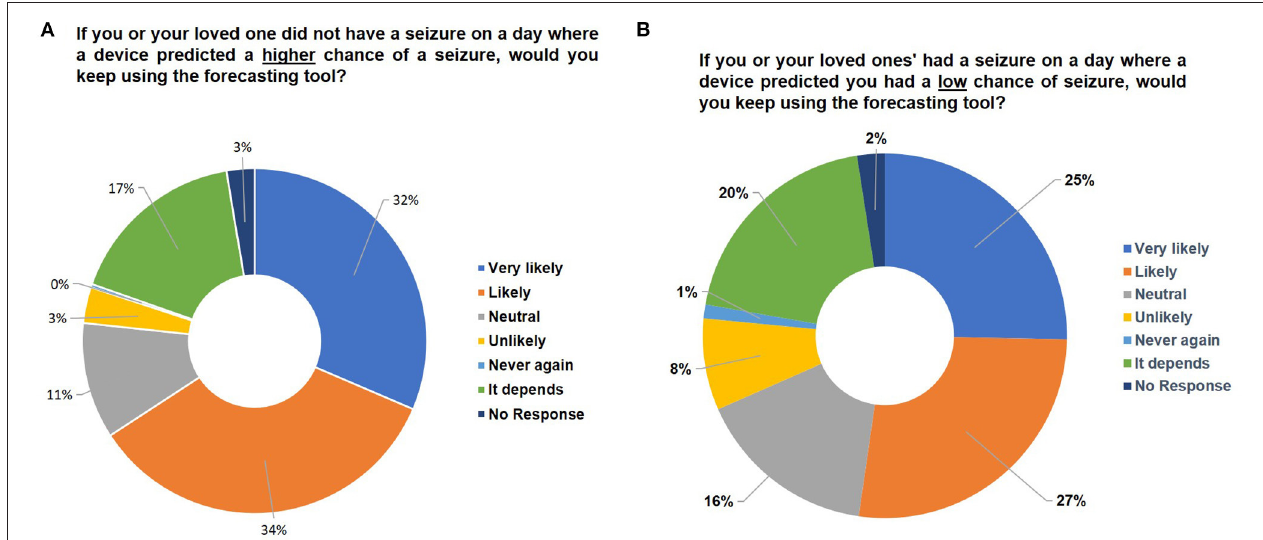
FIGURE 4 | Assessing user tolerance for error. Pie charts indicating the percentage breakdown of survey respondents that would keep using the forecasting tool if (A) there was no seizure on a day that forecasted high seizure risk or (B) there was a seizure on a day that forecasted low seizure risk. Note that all numbers have been rounded to two significant figures. No significant differences were found between segments using the Mann-Whitney U